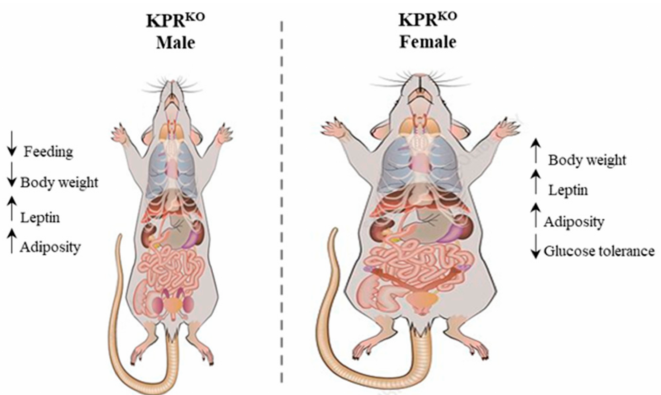
Figure 10. Role of kisspeptin signaling in metabolism. Kisspeptins (KP) and KP receptor (KPR) are present in liver, pancreas, fat, and gonad tissues. KPR KO male mice suffered from with feeding suppression and decreased body weight. They had increased adiposity but did not develop glucose intolerance. In contrast, KPR KO female mice gained bodyweight, higher leptin levels, marked adiposity with impaired glucose intolerance. The findings in KPR KO mice suggest that KP-signaling impacts energy expenditure, food intake and body weight gain in a sexually dimorphic